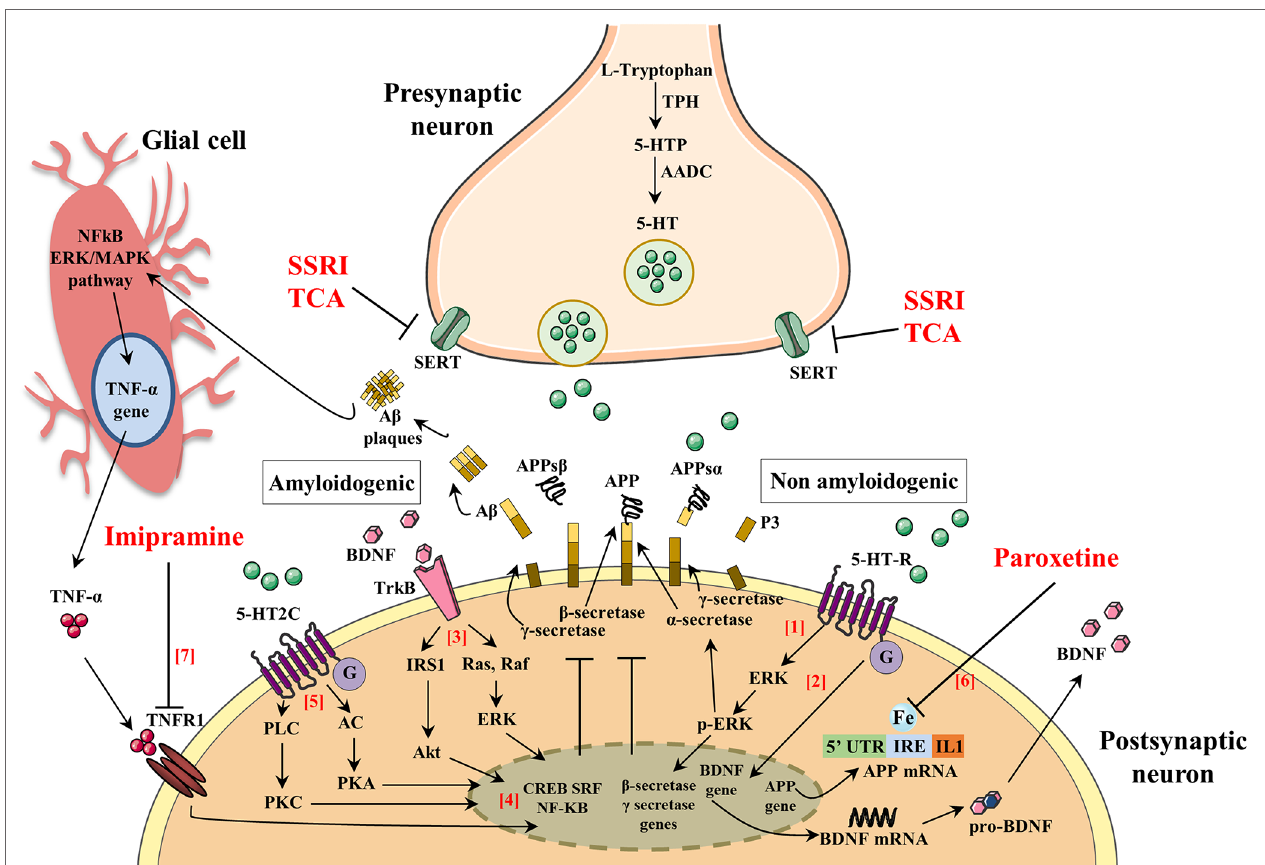
FIGURE 2 | The activation of serotonin receptors (5-HT-R) initiates a signaling cascade that leads to the activation of extracellular signal-regulated kinases (ERK). Once activated, p-ERK increases α -secretase activity and reduces β - and γ -secretase cleavage of APP (1). Brain-derived neurotrophic factor (BDNF) and serotonin (5-HT) regulate synaptic plasticity, neurogenesis, and neuronal survival. The activation of 5-HT-R stimulates the expression of BDNF, which in turn enhances the growth and survival of 5-HT neurons (2). BDNF binds to its high-affinity tyrosine receptor kinase B (TrkB) resulting in the recruitment of proteins that activate two different signal transduction cascades: (i) insulin receptor substrate-1 (IRS-1), phosphatidylinositol-3-kinase (PI-3K), and protein kinase B (Akt) and (ii) Ras, Raf, and extracellular signal regulated kinases (ERK) (3). BDNF signaling pathways activate one or more transcription factors that regulate the expression of genes encoding proteins. Such transcription factors include cAMP-response-element-binding protein (CREB), serum response factor (SRF), and nuclear factor kappa B (NF-kB) that exert an inhibitory action in the amyloidogenic pathways (4). 5-HT binds 5-HT-2C resulting in the recruitment of proteins that activate two different signal transduction cascades: (i) adenylate cyclase (AC), cAMP, and protein kinase A (PKA) and (ii) phospholipase C (PLC), diacylglycerol (DAG), and protein kinase C (PKC) (5). The 5-HT signaling pathway activates one or more transcription factors that regulate expression of genes encoding proteins (CREB, SRF, and NF-kB) leading to an inhibitory action in the amyloidogenic pathways (4). The 5’-untranslated region (5’UTR) of the APP mRNA is a key regulatory sequence that determines the amount of intracellular APP holoprotein present in brain-derived cells in response to interleukin-1 (IL-1) and iron (IRE). Paroxetine acts as an intracellular iron chelator to limit the translation of APP holoprotein guided by sequences of untranslated APP mRNA 5’UTR regions (6). Tumor necrosis factor α (TNF- α ) signaling, through tumor necrosis factor receptor 1 (TNFR1), mainly results in activation of the transcription factors NF-kB and induces pro-inflammatory effects that exacerbate neuroinflammation and secondary neuronal damage. Imipramine blocks TNF- α /TNFR1 signaling and prevents the appearance of cognitive deficits in AD and A β formation